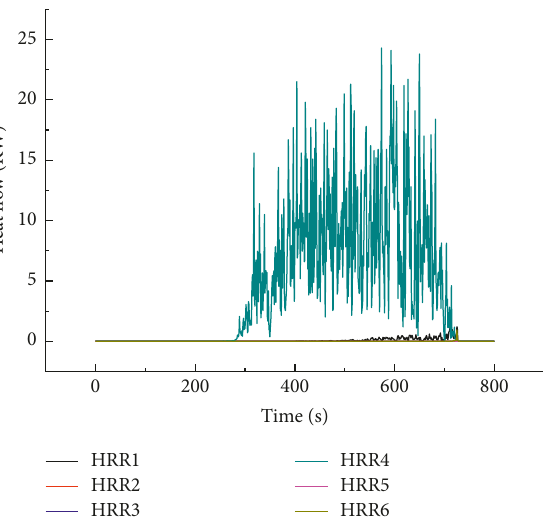
Figure 8: Temperature in case